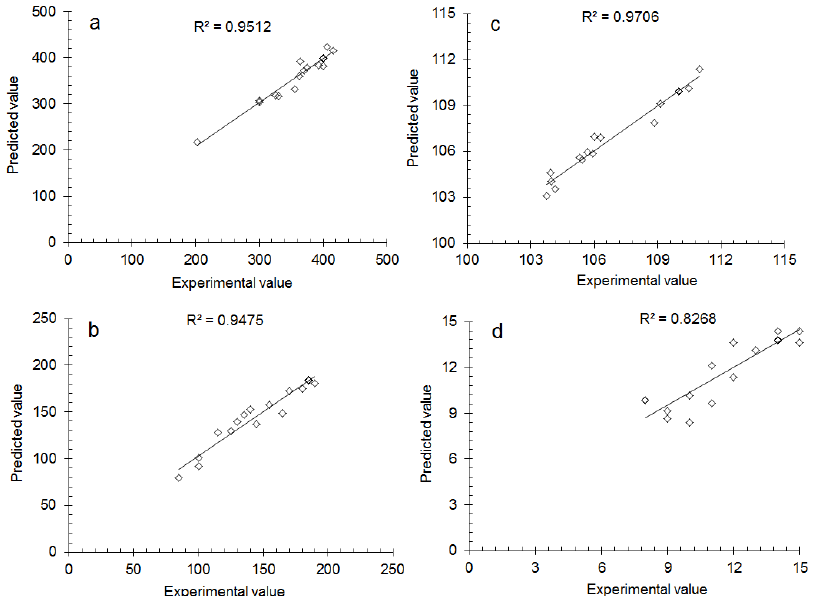
Fig. 2: Correlation plots of the predicted values of functional properties against experimental ones at the selected combinations of the input variables a) WAC, b) OAC, c) SC, and d) PSI